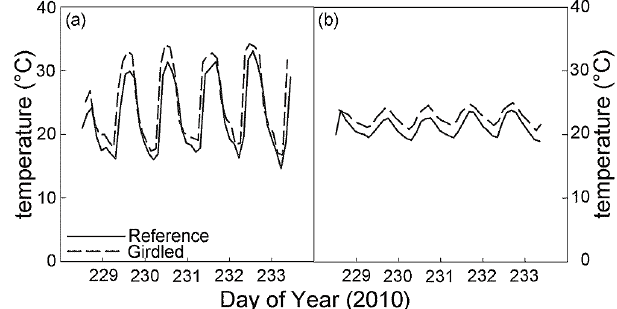
Fig. 4. Temperatures in the soil respiration chambers during the girdled–reference comparison experiment in the (a) air and (b) soil at 5cm; the reference site is indicated by the solid line and the gir- dled site by the dotted